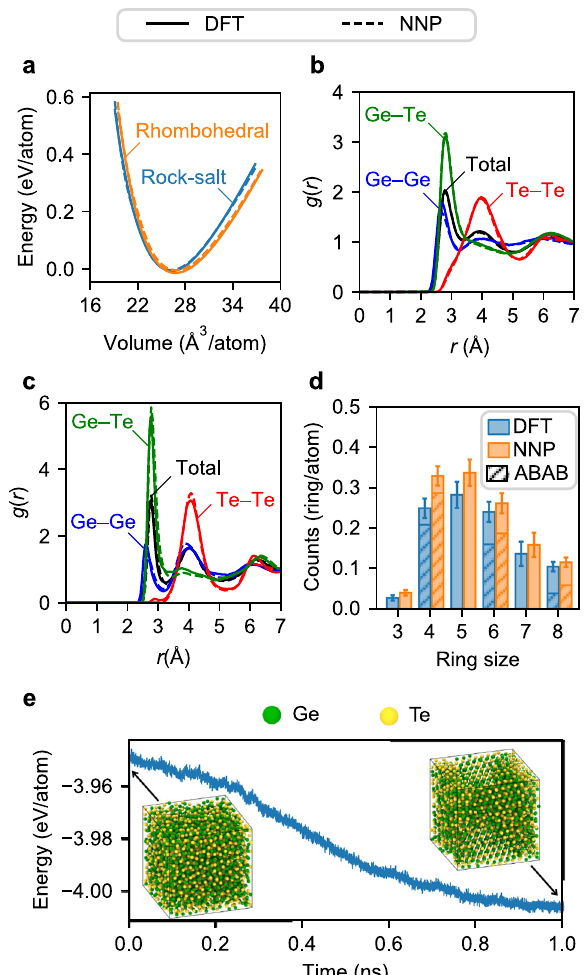
Fig. 4 Structural properties and crystallization behavior of GeTe obtained by the NNP. a The energy-volume relation for rock-salt and rhombohedral phases. The energy is referenced to that of the rock-salt phase at the equilibrium. b , c The total and element-resolved radial- distribution functions ( g ( r )) for liquid at 1000 K ( b ) and amorphous structures at 300 K ( c ). In a – c solid and dashed lines indicate DFT and NNP results, respectively. d Ring statistics of amorphous GeTe at 300K. The error bars indicate one standard deviation obtained from four independent MD simulations. The ABAB-type rings (A = Ge and B = Te) for even-membered rings are also shown. e The time evolution of potential energy during the crystallization. Initial and fi nal structures are shown as inset fi